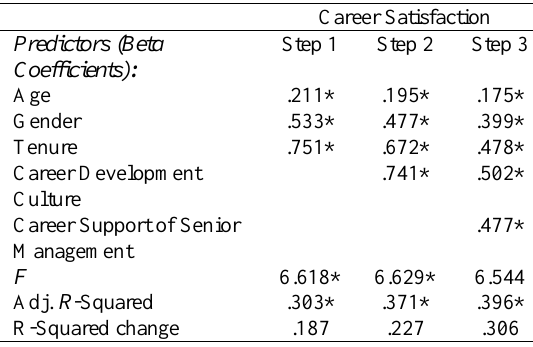
Table 6: Hierarchical Regression Examining the Impact of Career Development Culture and Career Support of Senior Management on